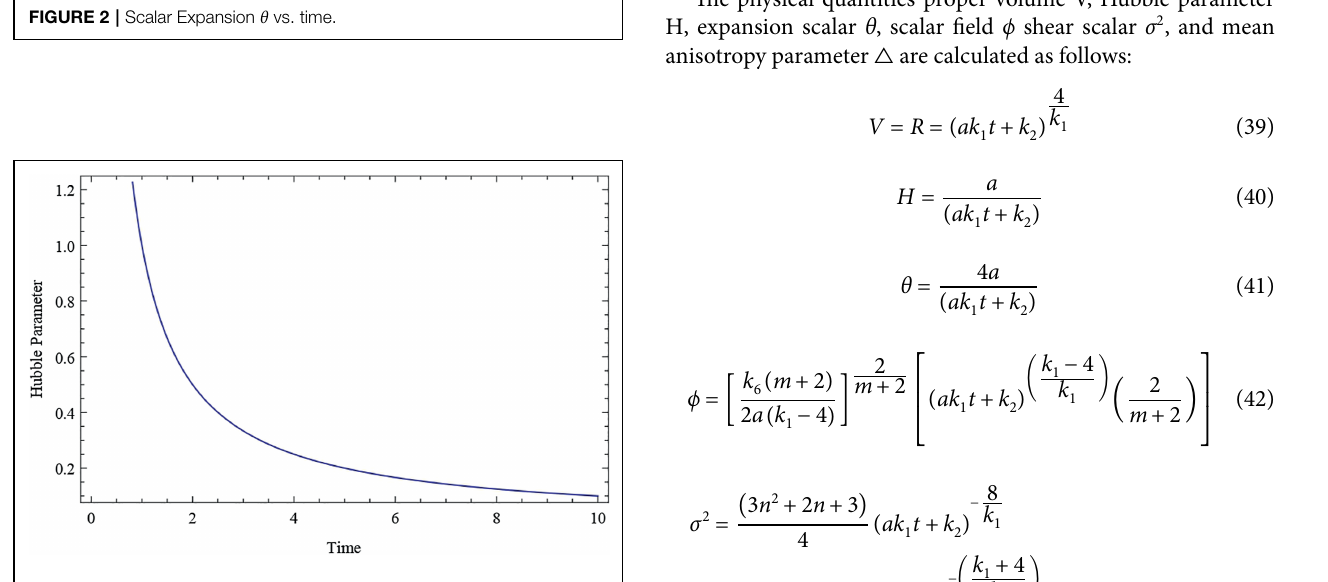
FIGURE 3 | Hubble Parameter H vs.